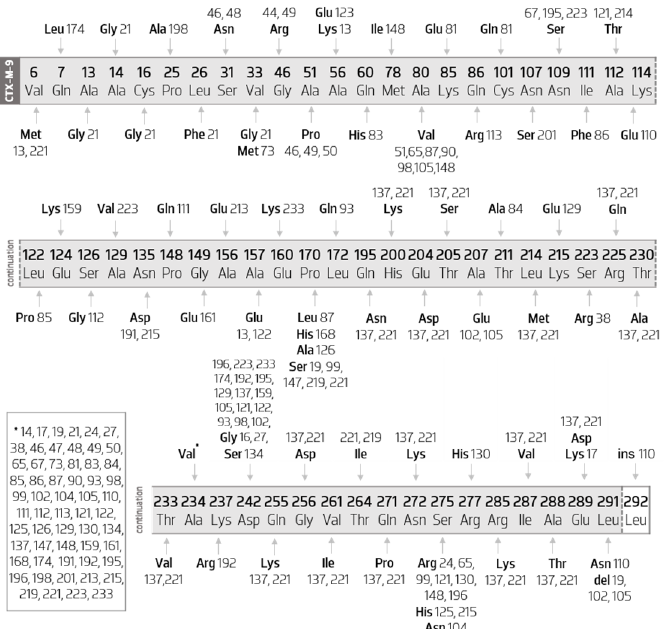
Figure 7. Diagram of the mutations of CTX-M-9-like members compared with the CTX-M-9 sequence. Scheme based on available sequences and phenotype in the Bacterial Antimicrobial Resistance Reference Gene Database. * indicates all the indexes of the CTX-M-9 like members that present a substitution of an alanine by a valine at position 234.